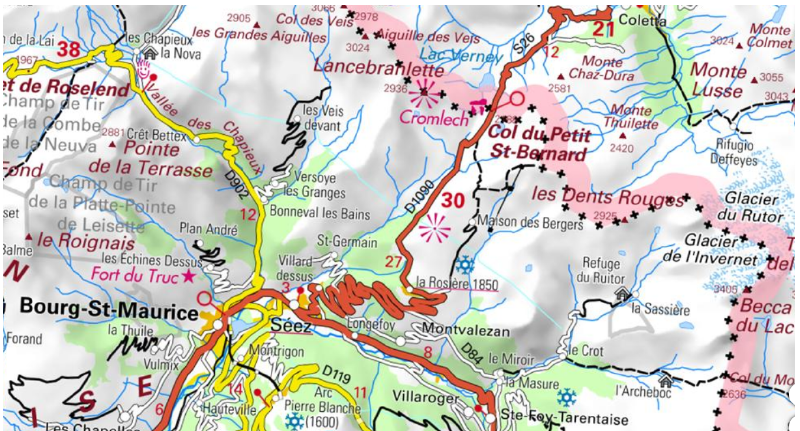
Figure 5. The map that caused the France and Italy border disorientation experience, where the border is the wide pink line (source: